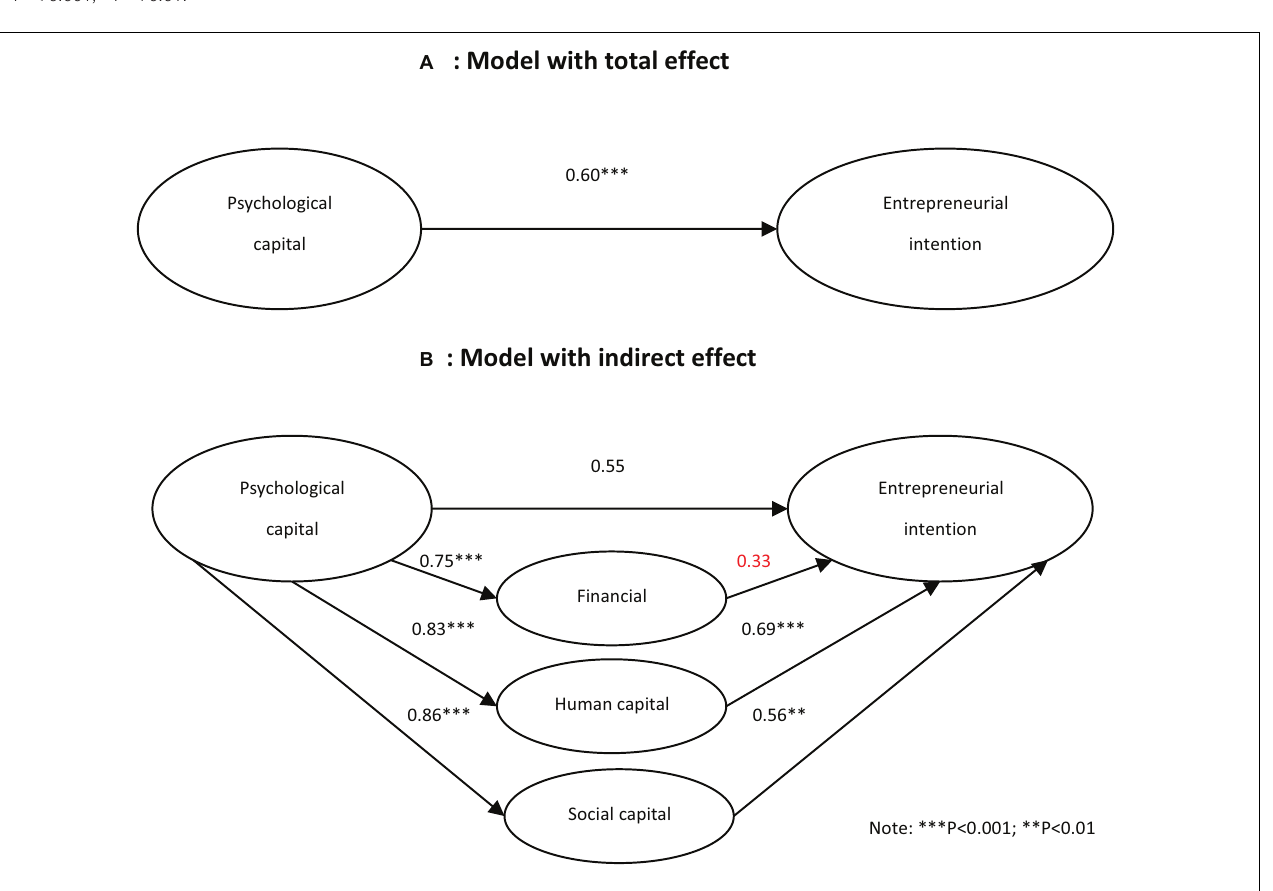
FIGURE 2 | Path model analysis